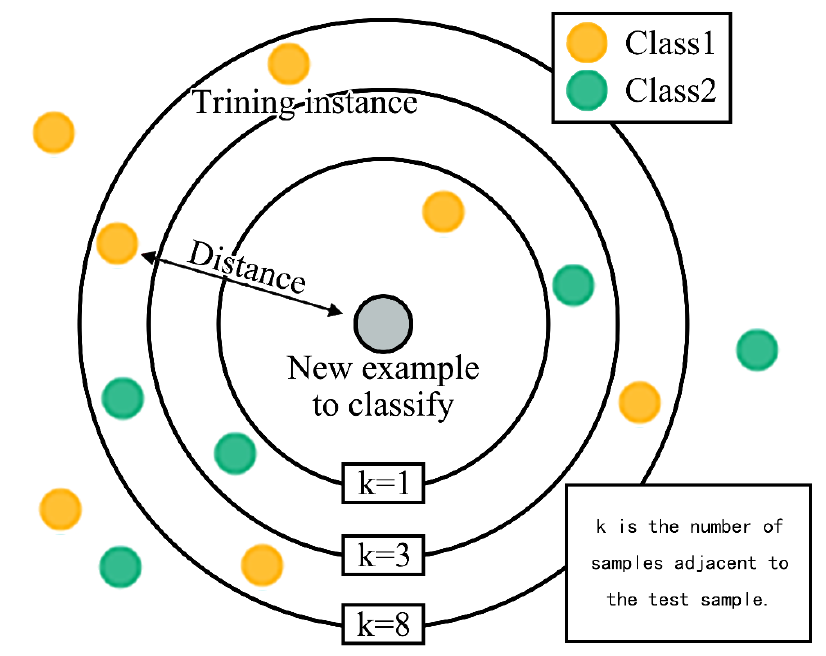
Figure 5. Example of KNN classification.